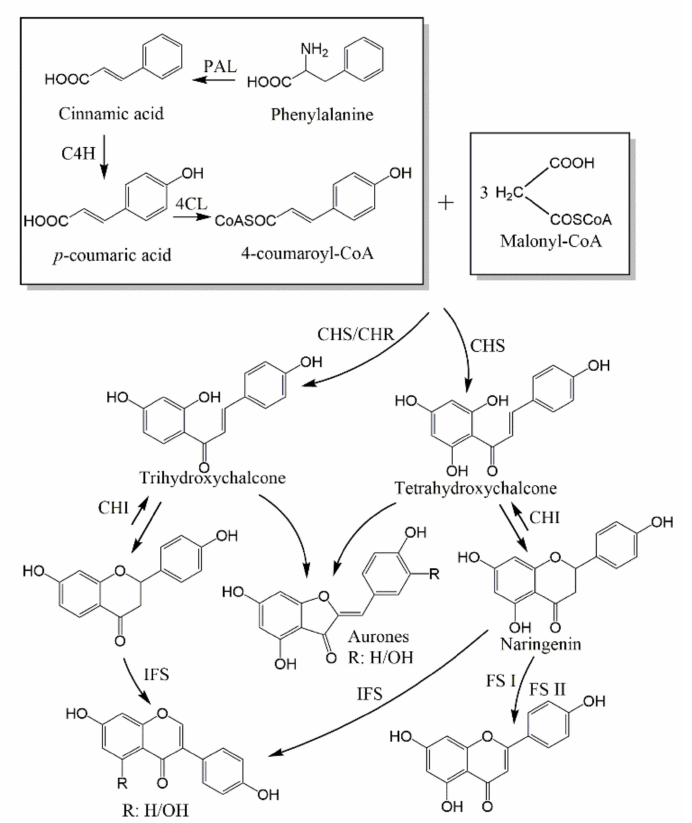
Figure 13. The biosynthesis of flavonoids. Enzyme names are abbreviated as follows: cinnamate-4- hydroxylase (C4H), chalcone isomerase (CHI), chalcone reductase (CHR), chalcone synthase(CHS), 4-coumaroyl:CoA-ligase (4CL), flavone synthase (FS I and FS II), isoflavone synthase (IFS), and Phe ammonia-lyase